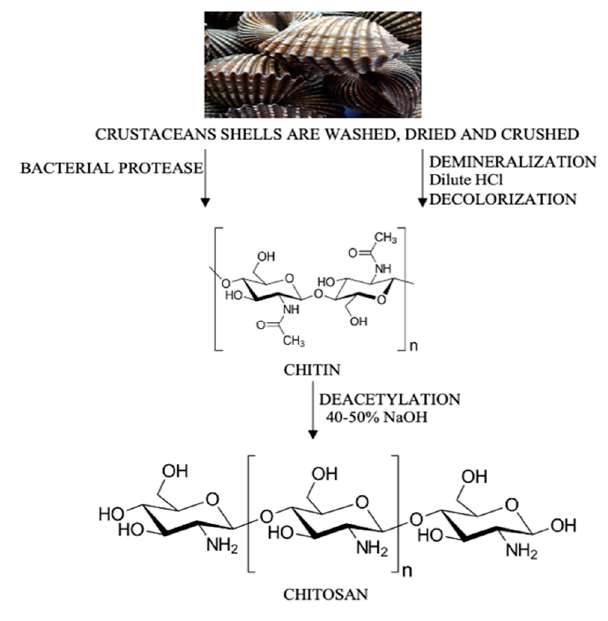
Figure 2. Chitosan Figure 2. Chitosan production.